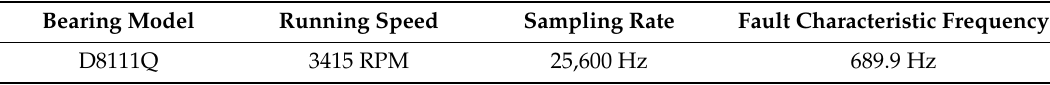
Table 3. Relevant experimental settings.